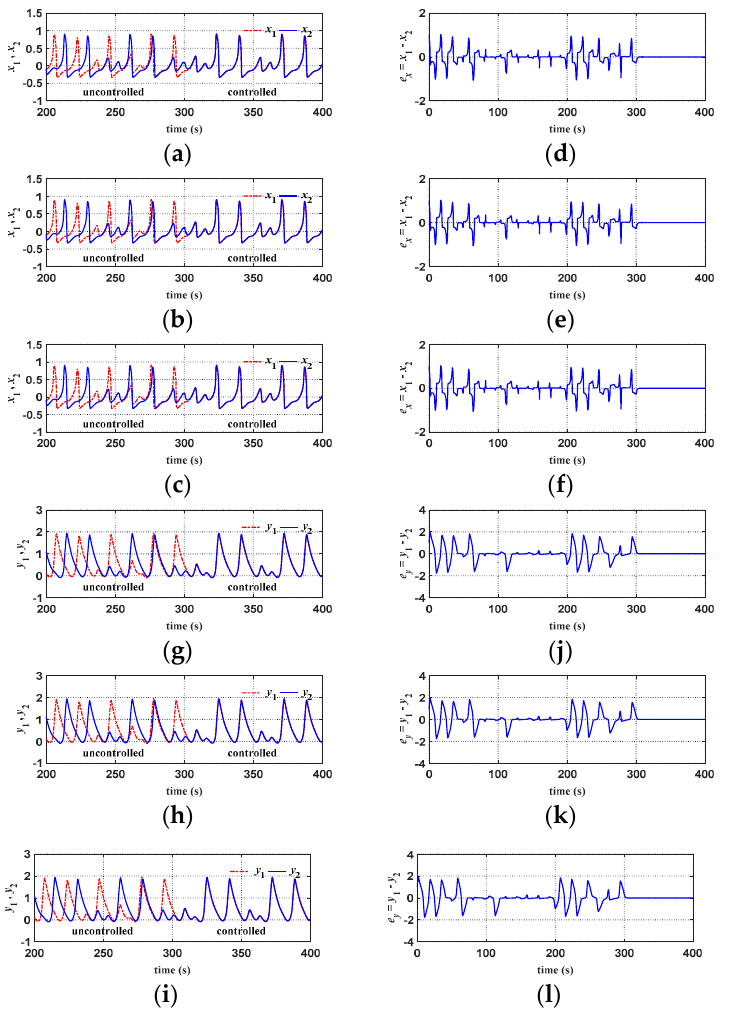
Figure 17. Comparisons on simulation results of chaotic system synchronization control ( g = 0.01, cut-in control at 300 sec): ( a ) x 1 , x 2 response for CMAC; ( b ) x 1 , x 2 response for FCMAC; ( c ) x 1 , x 2 response for ATFSORC; ( d ) Error e x for CMAC; ( e ) Error e x for FCMAC; ( f ) Error e x for ATFSORC; ( g ) y 1 , y 2 response for CMAC; ( h ) y 1 , y 2 response for FCMAC; ( i ) y 1 , y 2 response for ATFSORC; ( j )